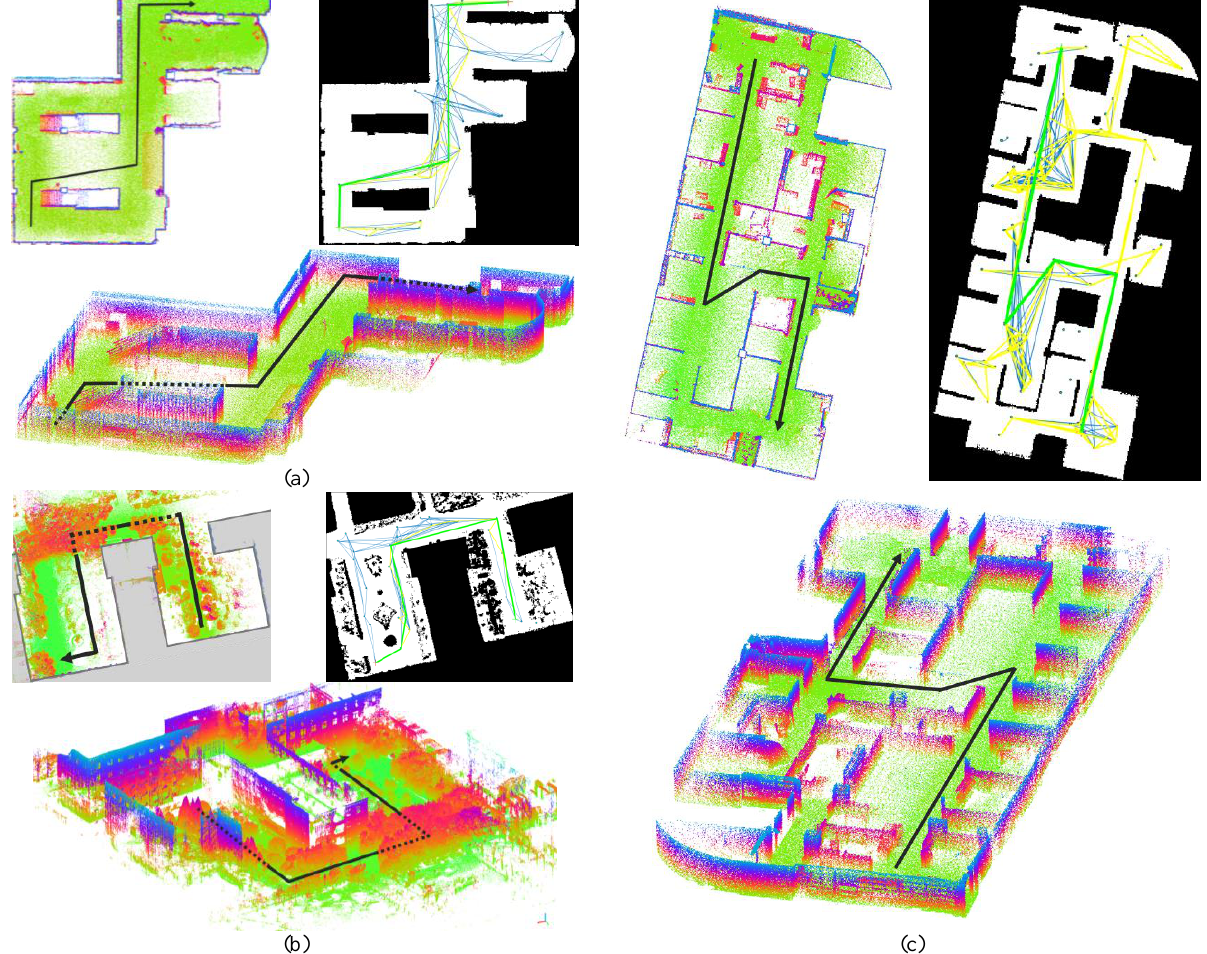
Figure 5 . Point cloud and planning results of Map 1 (a), Map 2(c) and Map 3 (b). The first row of each sub-figure is the top view of its point cloud and planning result, and the second row is the overview of the point cloud from another angle. In the figures of point clouds, the point clouds are rendered in height ramp, and the black lines represents the path result. In the figures of planning results, the blue lines represent the edges in the connection network, the yellow lines represent the updated path sections, the cyan lines represent the collision-free path before optimization, and the green lines represent the finally optimal